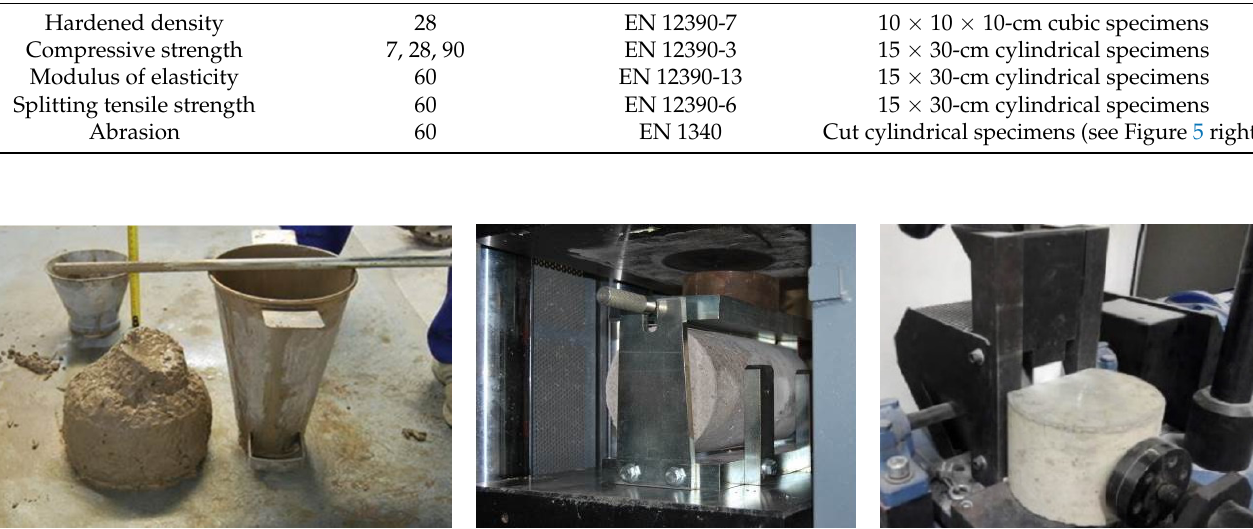
Figure 5. Consistency of the SAC/M mix ( left ); splitting-tensile-strength test ( middle ); abrasion-resistance test ( right ).